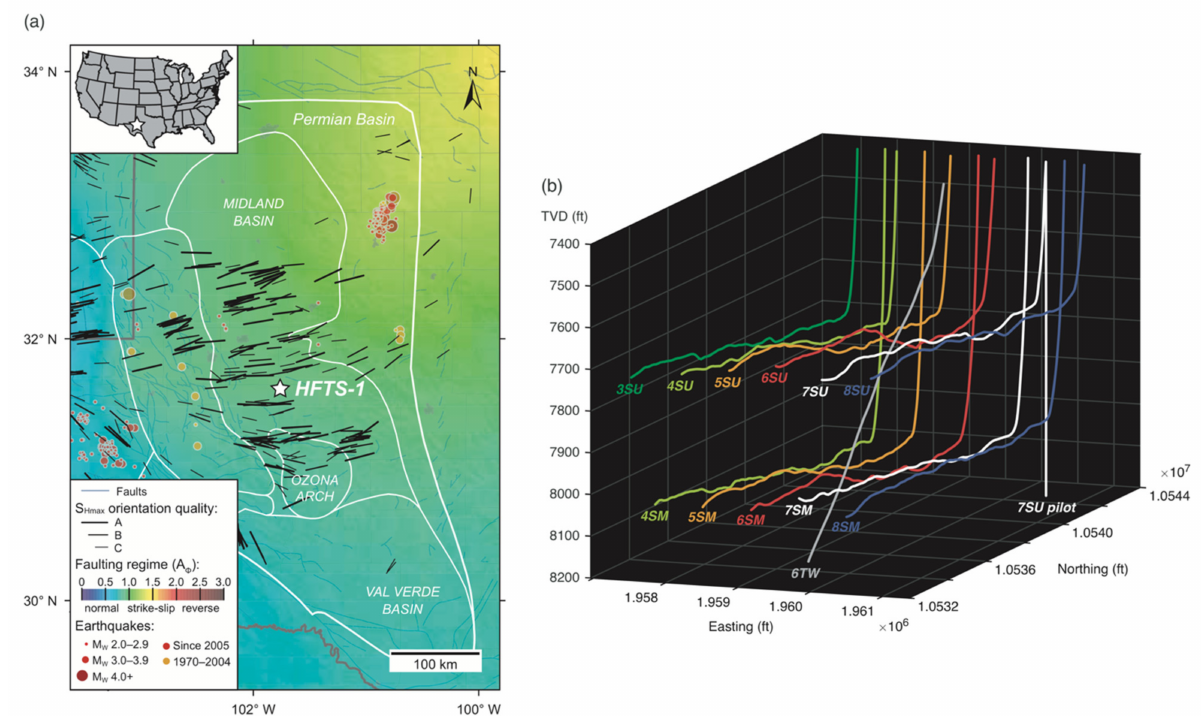
Figure 1. ( a ) Regional stress map showing the location of the Hydraulic Fracture Test Site-1 (HTFS-1) in an area of strike-slip/normal faulting (adapted from Lund Snee and Zoback, 2018, 2020). The direction of the maximum horizontal compressive stress, S Hmax , (black lines) is approximately E-W. ( b ) A vertical pilot well (7SU pilot) and a ‘wine rack’ pattern of horizontal wells were drilled N to S into the Upper (-SU) and Middle Wolfcamp (-SM) shale units. After hydraulic fracturing, a deviated well (6TW) was drilled through the stimulated volume.2.2. Well Logs, Core, and Microseismic